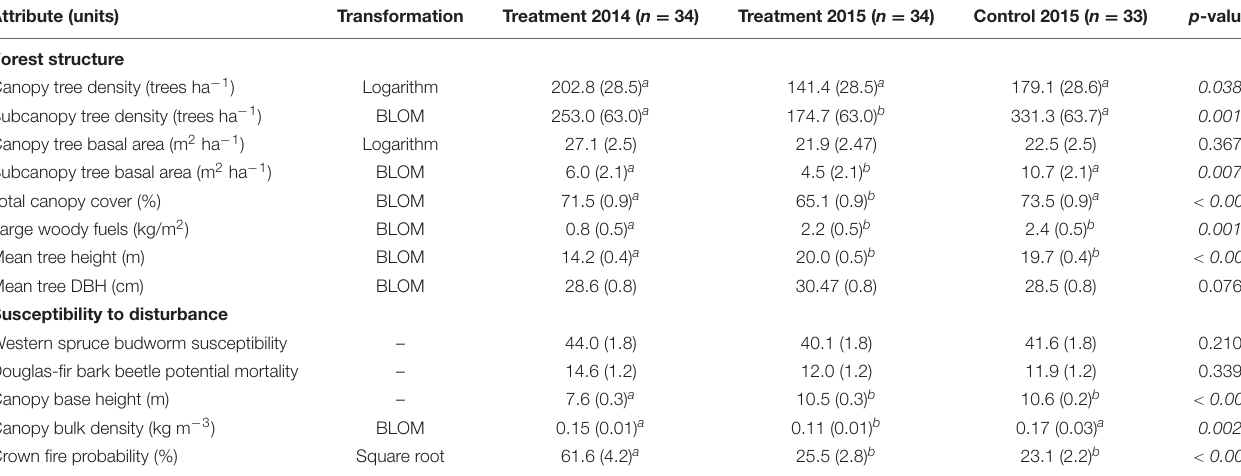
TABLE 1 | Comparison of forest structure attributes and susceptibility to disturbance among plots in the before and after treatment and relative to the control area.